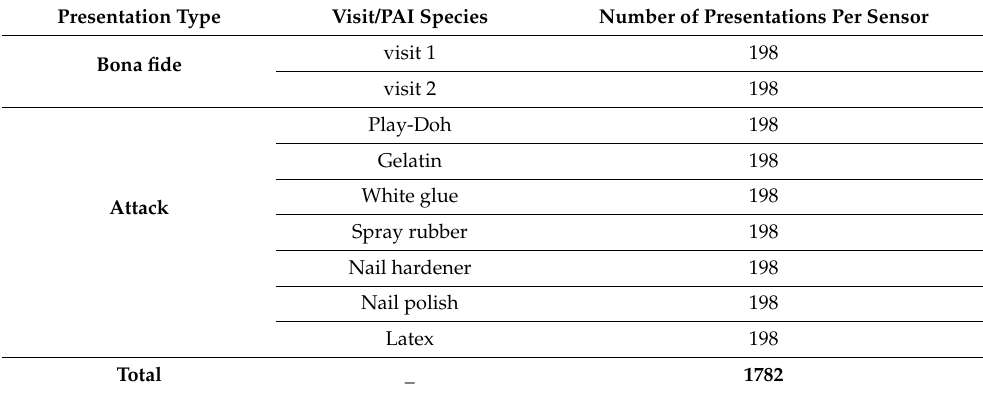
Table 3. Fingerprint presentation types in the database (the same protocol is applied for the 2 sensors).